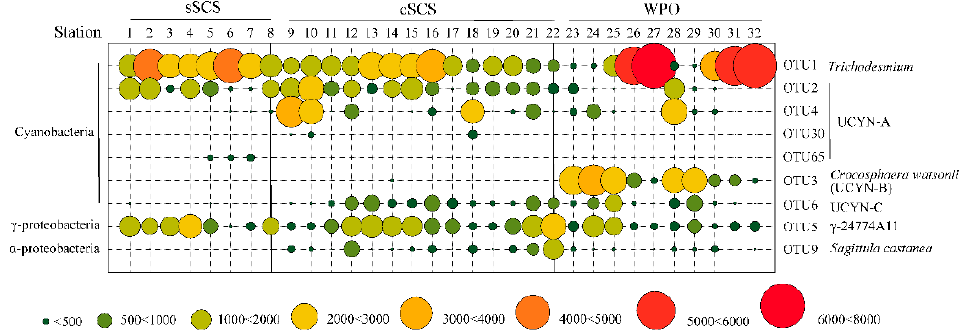
Figure 3. The relative contribution of dominant taxa of diazotrophs in study stations (OTU num- bers).